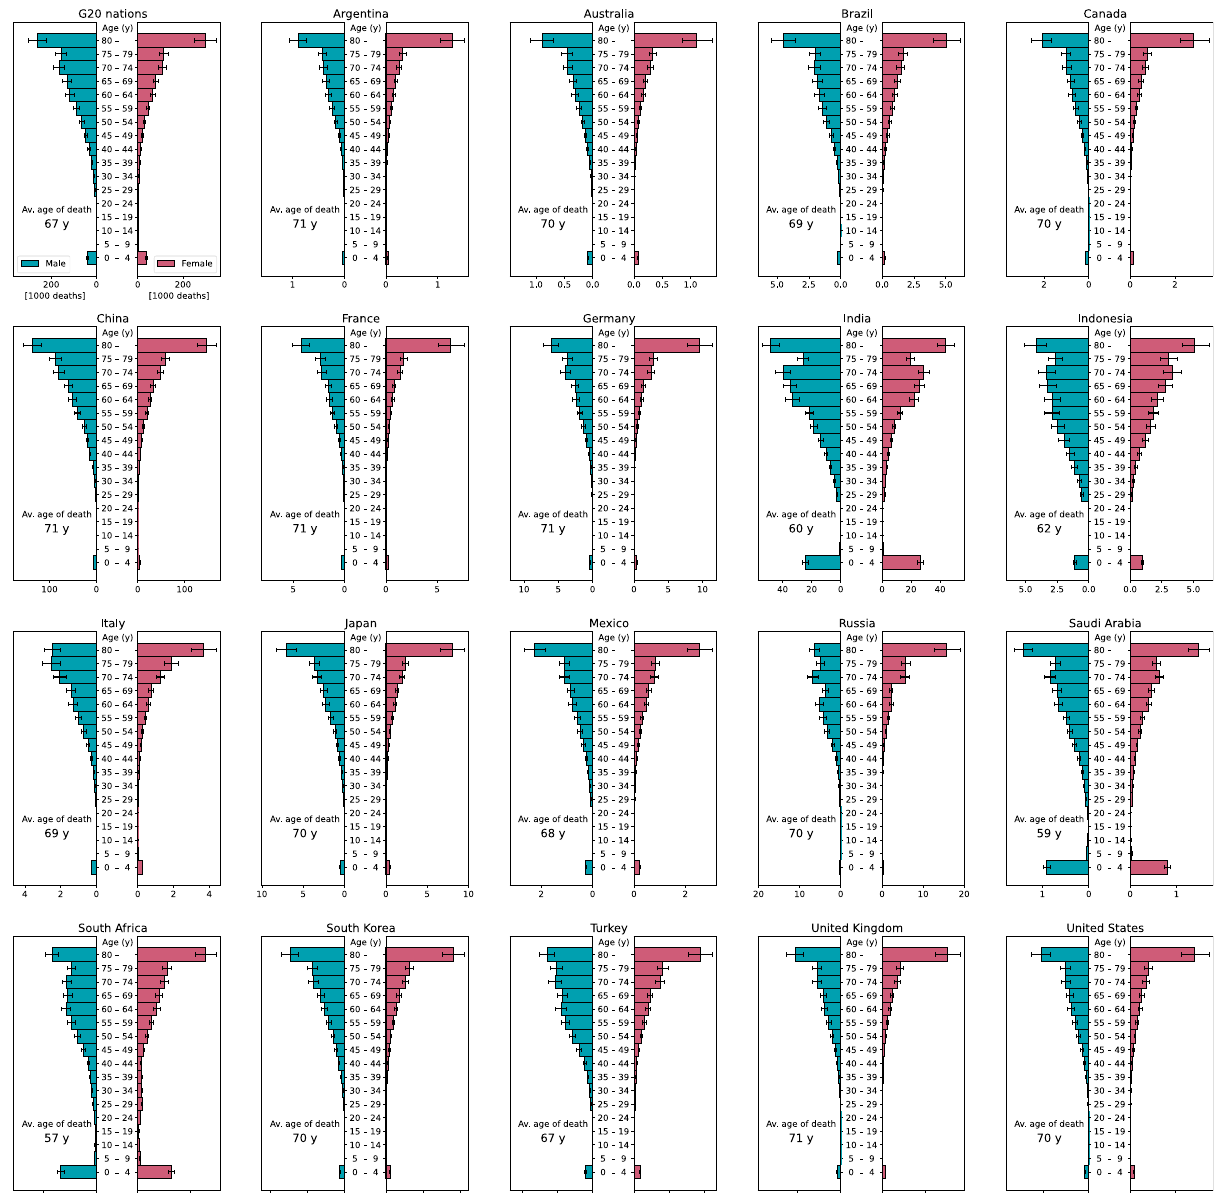
Fig. 3 Age and gender composition of PM 2.5 premature death footprint in each G20 nation. Error bars indicate 95% con fi dence intervals. The centre of the bars indicates the mean